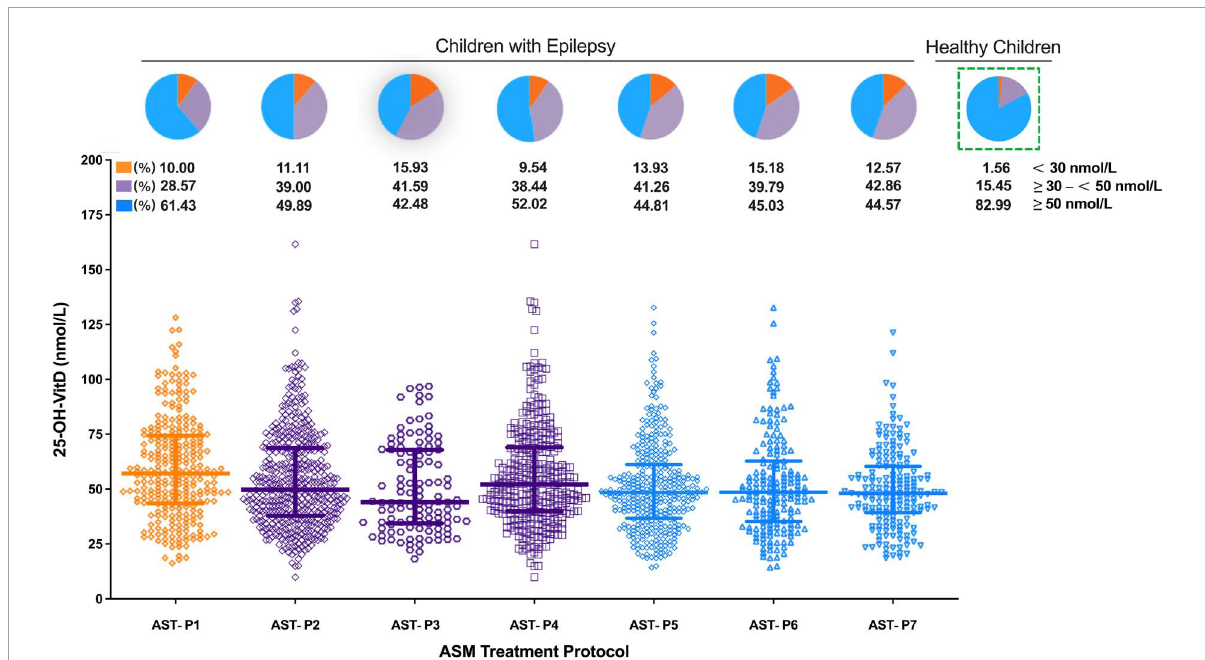
FIGURE7 Comparison in serum 25-OH-VitD status of children with epilepsy with different ASM treatment protocols and proportion of VitD sufficiency, insufficiency and deficiency (including healthy children).